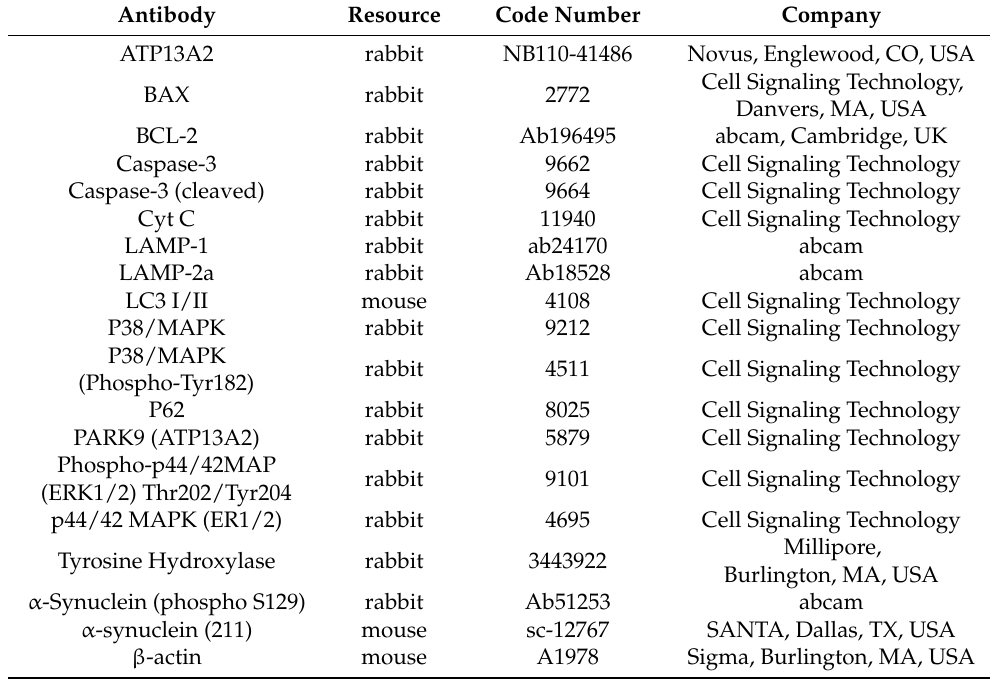
Table 2. List of primary